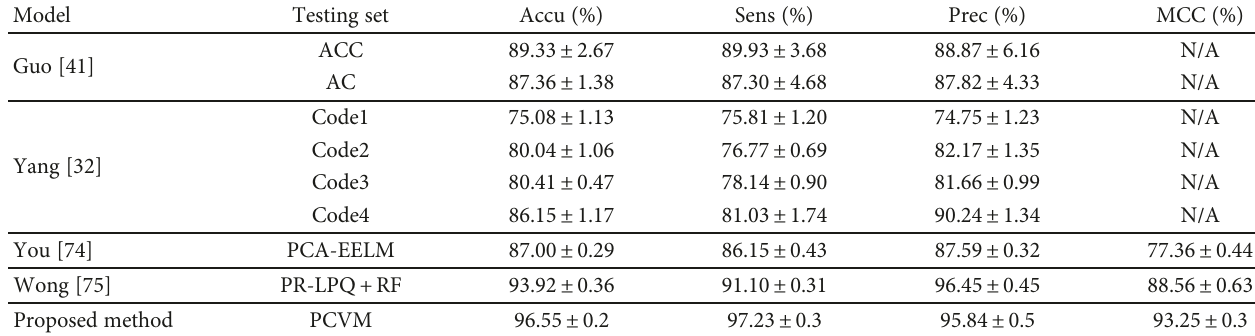
Table 7: Performance comparison of di ff erent methods on the S. cerevisiae dataset.